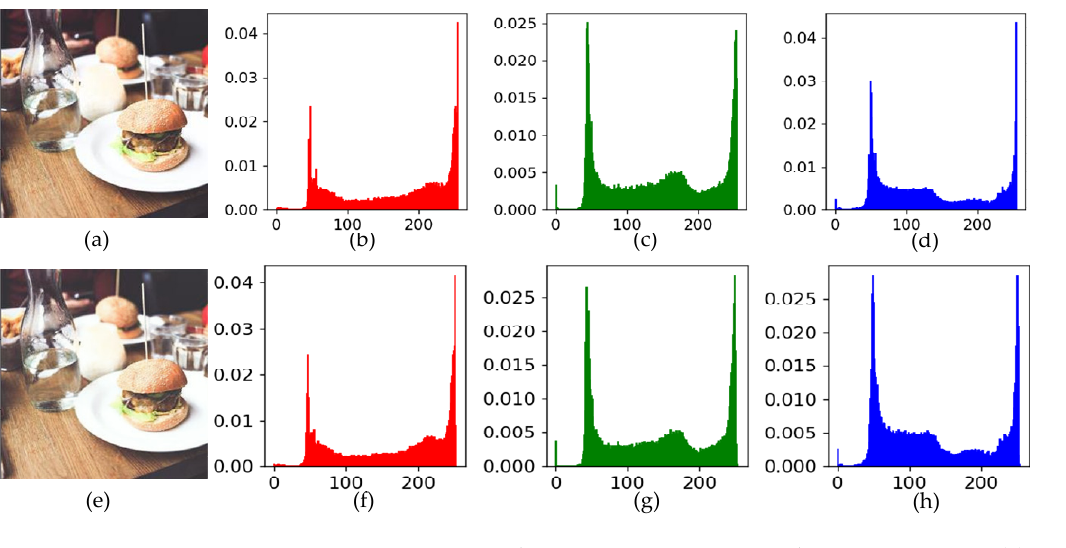
Figure 7. Histogram comparison between a carrier image and a container image: ( a ) carrier image; ( b – d ) histograms of pixel values of ( a ) for the three (RGB) channels, respectively; ( e ) container image; ( f – h ) histograms of pixel values of ( e ) for the three (RGB) channels, respectively.